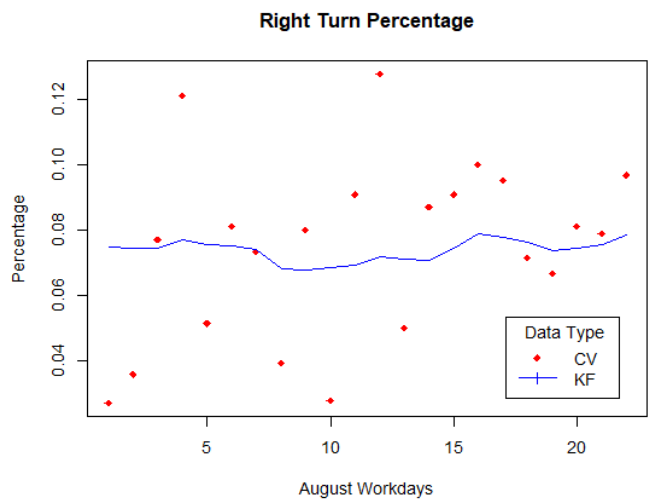
Figure 9. Northbound Right Turns 4:15 to 6:15 p.m. August, 2021.